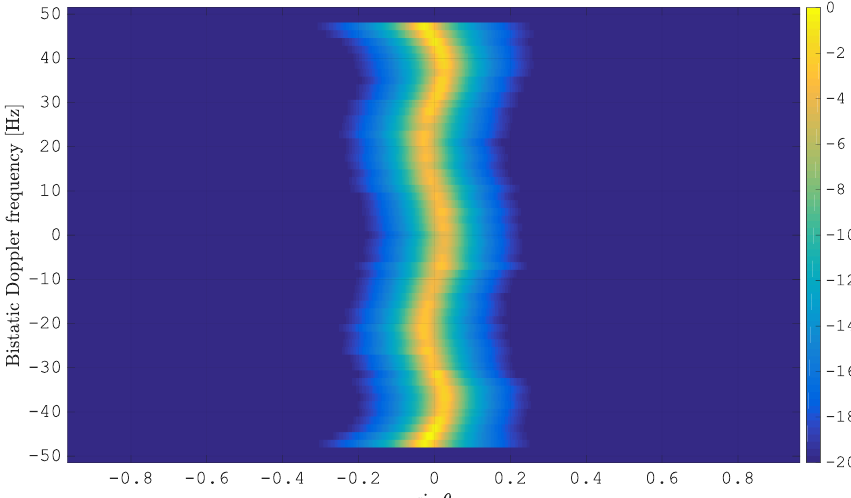
Figure 4. Minimum variance power spectrum estimated from simulated clutter after flex-DPCA. Due to antenna pattern errors, the maximum values show a severe deviation from the